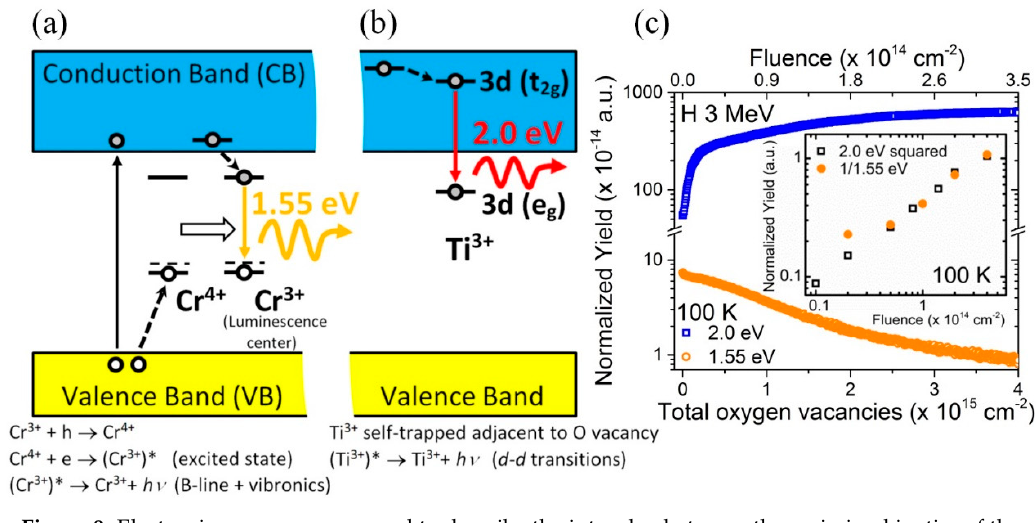
Figure 9. Electronic processes proposed to describe the interplay between the emission kinetics of the 1.55 eV emission of Cr 3+ ( a ) and the 2.0 eV band of oxygen vacancies ( b ), during 3 MeV H irradiation at 100 K. The plot in ( c ) evidences a clear correlation between the square of the yield at 2.0 eV and the inverse of the yield at 1.55 eV as a function of fluence [5]. This figure has been reprinted from Crespillo et al. [9], Copyright (2018), with permission from Elsevier.